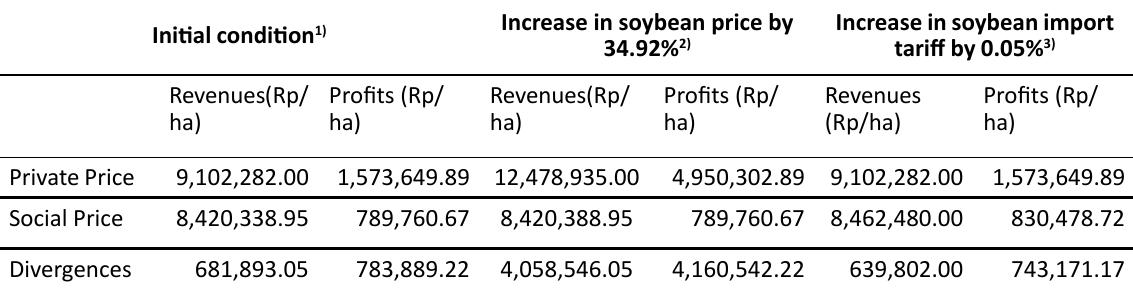
Table 3: Results of the Sensitivity Analysis Profits (Rp/ ha)